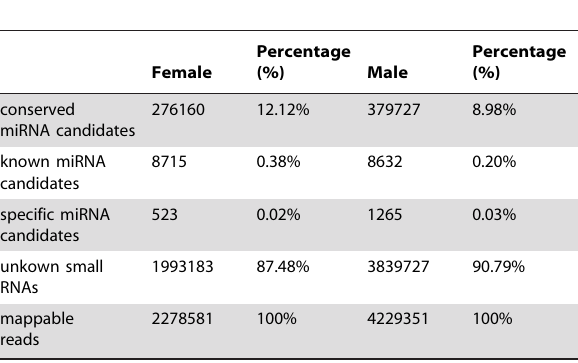
Table 2. Annotations of mappable reads in the female and male libraries of E. sinensis